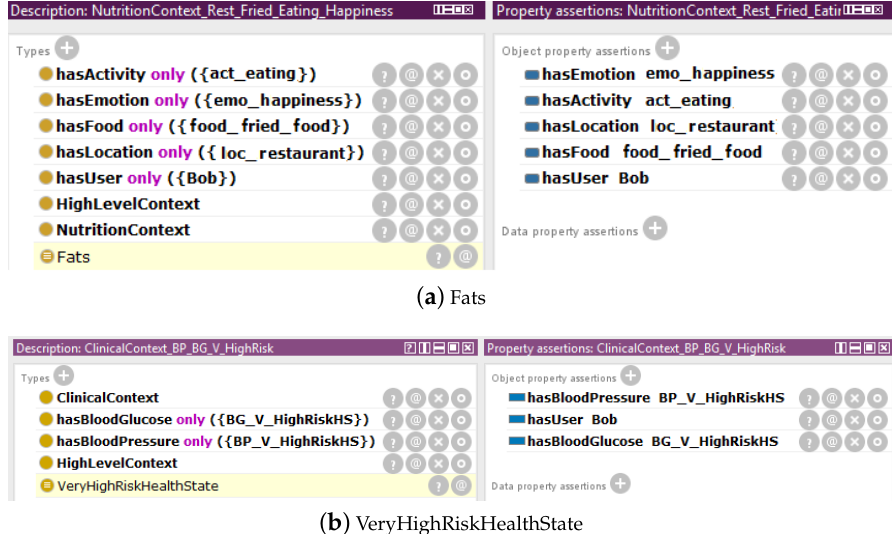
Figure 6. Instances of the NutritionContext and ClinicalContext classes which are classified as being members of the defined NutritionContext and ClinicalContext subclasses using the Pellet reasoner in Protégé. The inferred classes are highlighted in yellow: ( a ) Fats and ( b ) VeryHighRiskHealthState are inferred.